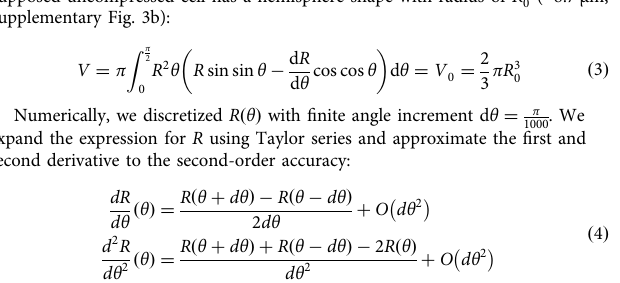
as axial tension, T axial . c 2